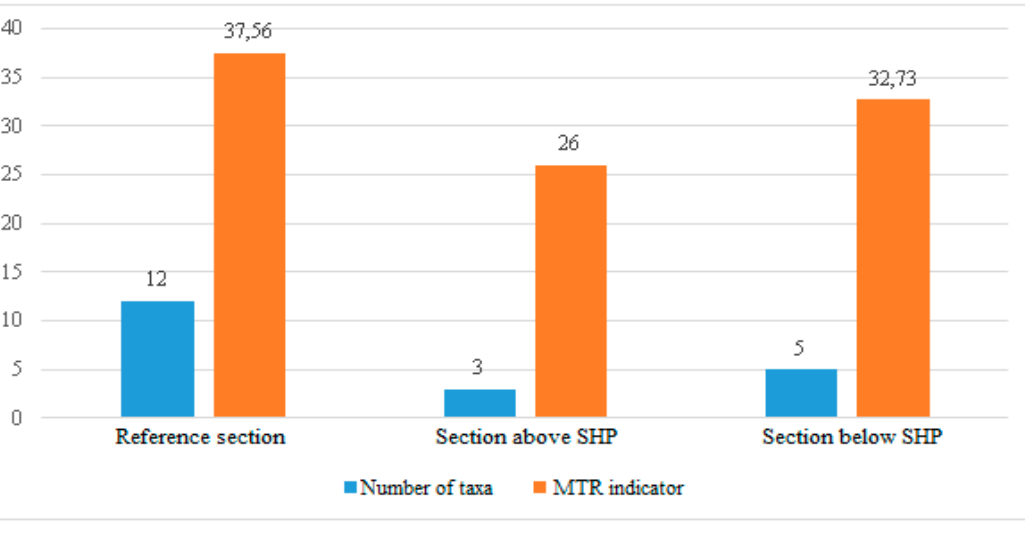
Figure 3. Number of taxa and MTR in each research section, the Ś l ę za, May 2017. Table 9. Summary of MTR results, May 2017, reference section on the Ś l ę za.